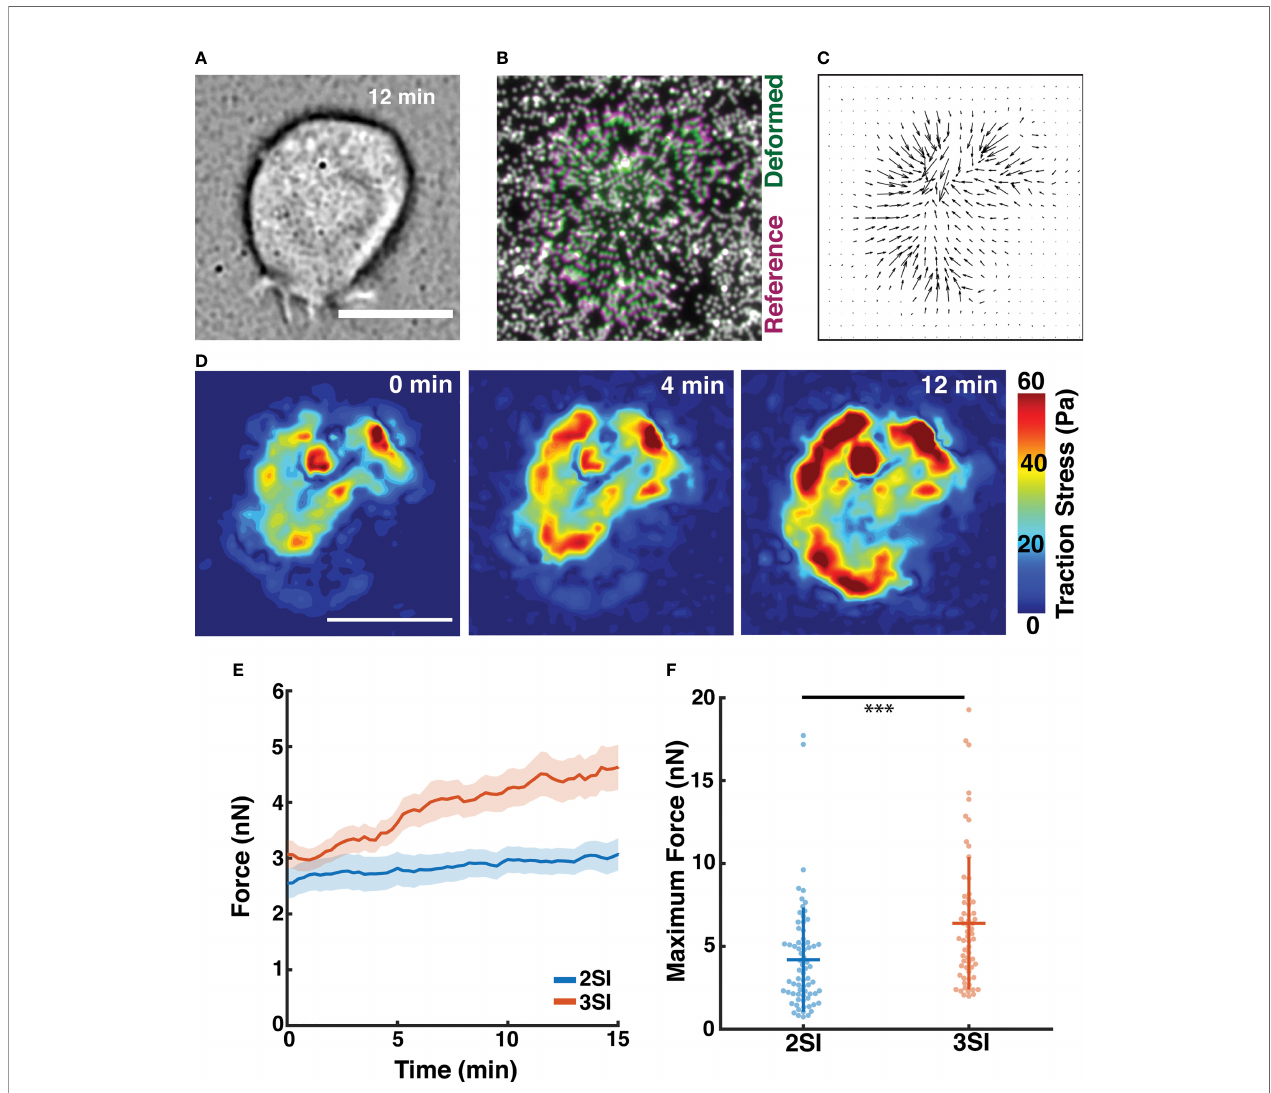
FIGURE 5 | Traction force microscopy reveals 3SI CTLs generate stronger traction forces. (A) Bright fi eld image of a 3SI CTL spreading on a polyacrylamide hydrogel substrate at 12 minutes of imaging. (B) Composite fl uorescence image showing displacement of fl uorescent beads embedded in the gel surface during spreading of the cell in (A) . Bead positions for deformed and undeformed (reference) states of the hydrogel are indicated by green and magenta, respectively. Undisplaced beads are indicated by white. (C) Traction stress vectors calculated for the cell in (A) . (D) Spatial distribution of traction stress magnitude associated with the cell in (A) at time points between 0 and 12 minutes of imaging. (E) Evolution of integrated traction force over the course of imaging for 2SI and 3SI CTLs. The trends are reported as mean ± sem. (F) Maximum traction force generated by 2SI and 3SI cells during the imaging period. n = 72 cells for 2SI and 63 cells for 3SI. Data taken from 4 independent experiments. *** p-value < 0.0001. All scale bars indicate 10 m